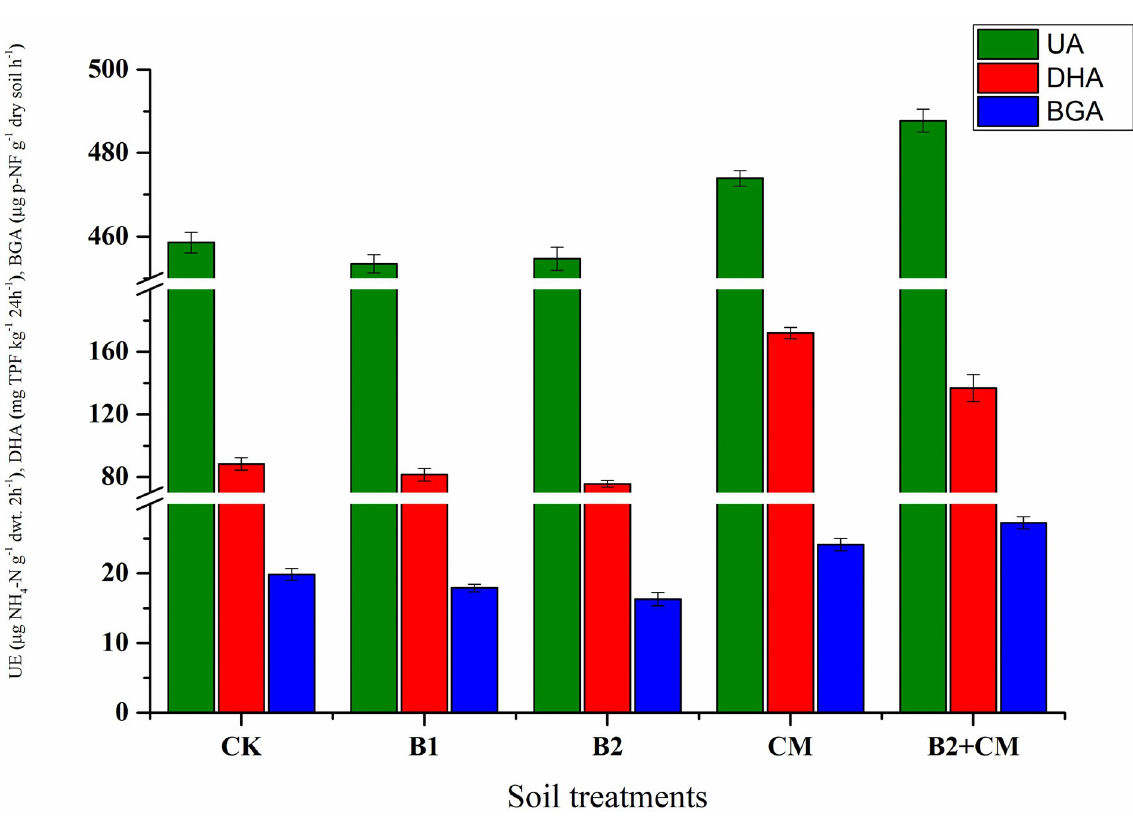
Fig 4. Urease (UA), dehydrogenase (DHA) and β -glucosidase activity (BGA) in soils was influenced by biochar and compost application (P < 0.05). Treatments include unamended control (CK), 12.5 t ha -1 biochar (B1), 25 t ha -1 biochar (B2), 5 centimeter (cm) green waste compost (CM), and 12.5 t ha -1 biochar and 5 cm compost (B1+CM).